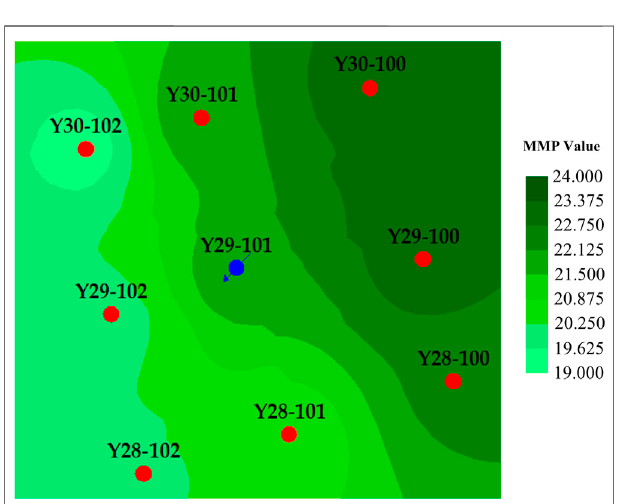
FIGURE 10 | MMP planar distribution of Y29-101 well group.